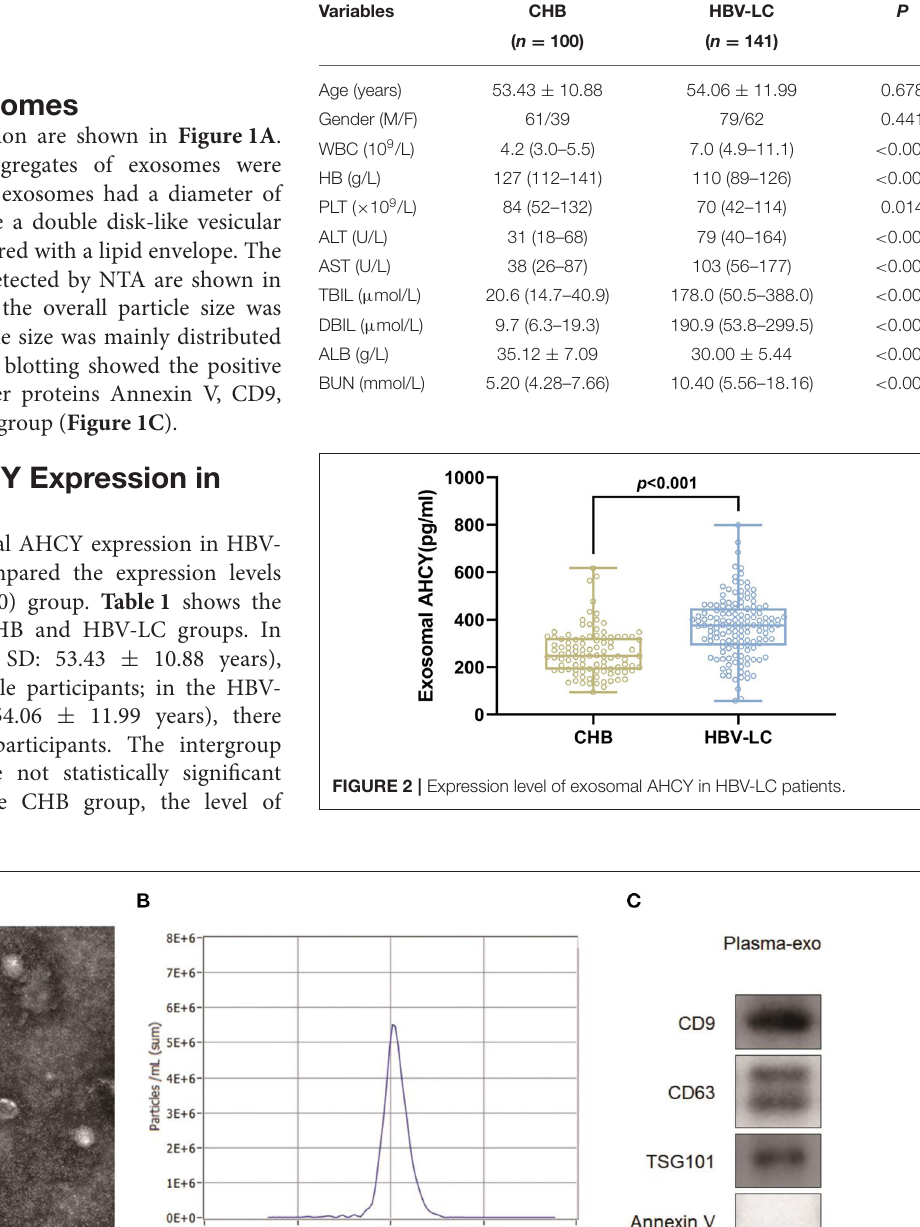
Frontiers in Medicine |